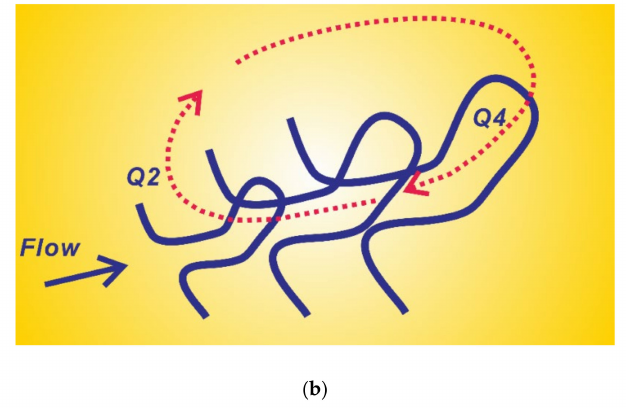
Figure 1. The formation of a large eddy due to the solenoidal e ff ects of the hairpin vortex packets ( a ) development of the hairpin vortex, and ( b ) development of a large eddy out of the hairpin vortex packets (modified from Cho [3] and Adrian [5]).